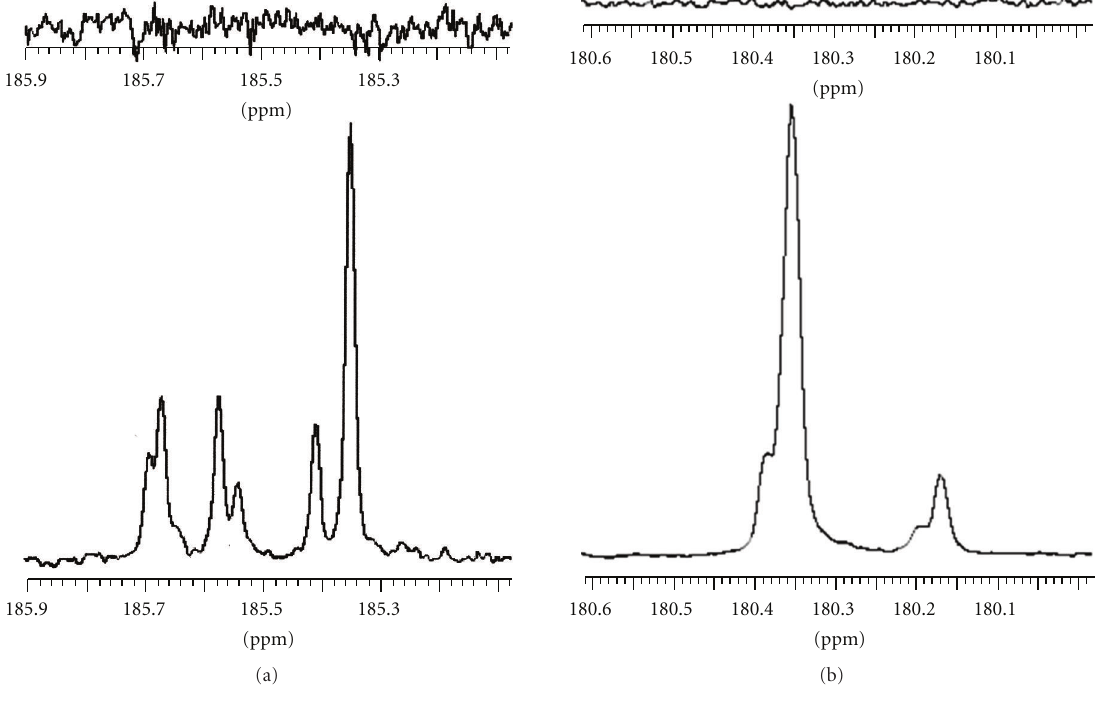
Figure 3: 13 C NMR spectrum of CTO after and before hydrogenation. The left spectra belong to RA (184–186 ppm). The right spectra to FFA (180-181ppm).